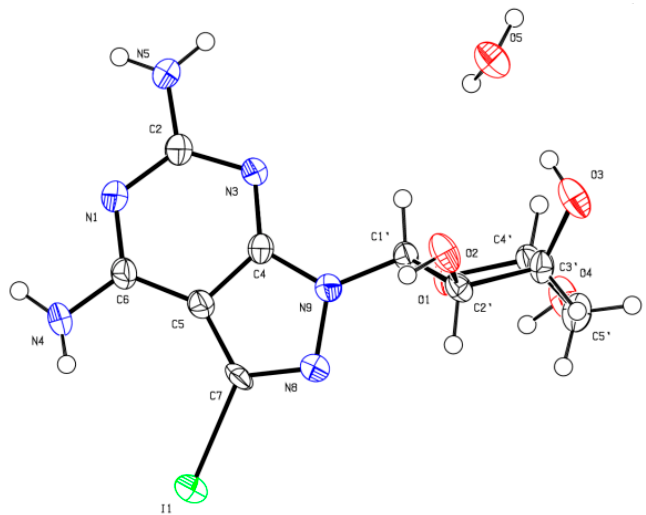
Figure 6. Molecular structure of compound 8 taken from the X-ray analysis. Crystal Data for C 10 H 15 IN 6 O 5 ( M = 426.18 g/mol): monoclinic, space group P2 1 (no. 4), a = 5.08845 (13) Å, b = 12.7514 (2) Å, c = 11.3200 (2) Å, β = 91.4146 (19)°, V = 734.28 (3) Å 3 , Z = 2, T = 293 (2) K, μ (CuK α ) = 17.478 mm − 1 , Dcalc = 1.928 g/cm 3 , 5309 reflections measured (7.812° ≤ 2 Θ ≤ 134.094°), 2616 unique ( R int = 0.0300, R sigma = 0.0391) which were used in all calculations. The final R 1 was 0.0286 (I > 2 σ (I)) and wR 2 was 0.0711 (all data).